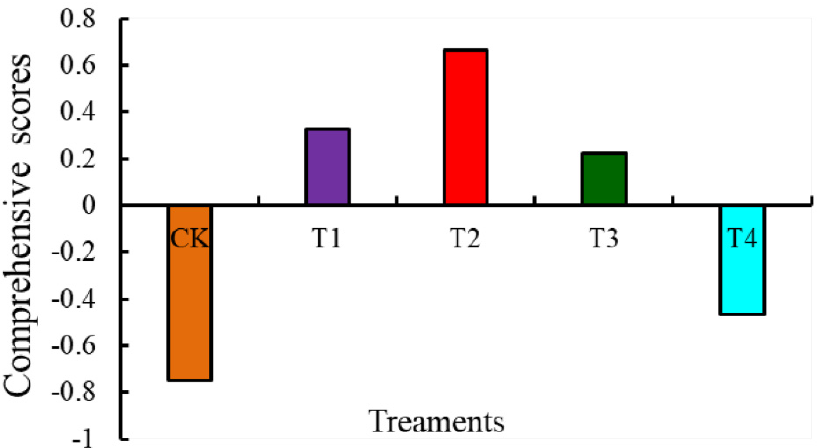
Figure 7. Comprehensive scores of tomato fruit quality and antioxidant capacity under different levels of water deficit. The abbreviations CK, T1, T2, T3, and T4 are defined in the footnote of Table 1.